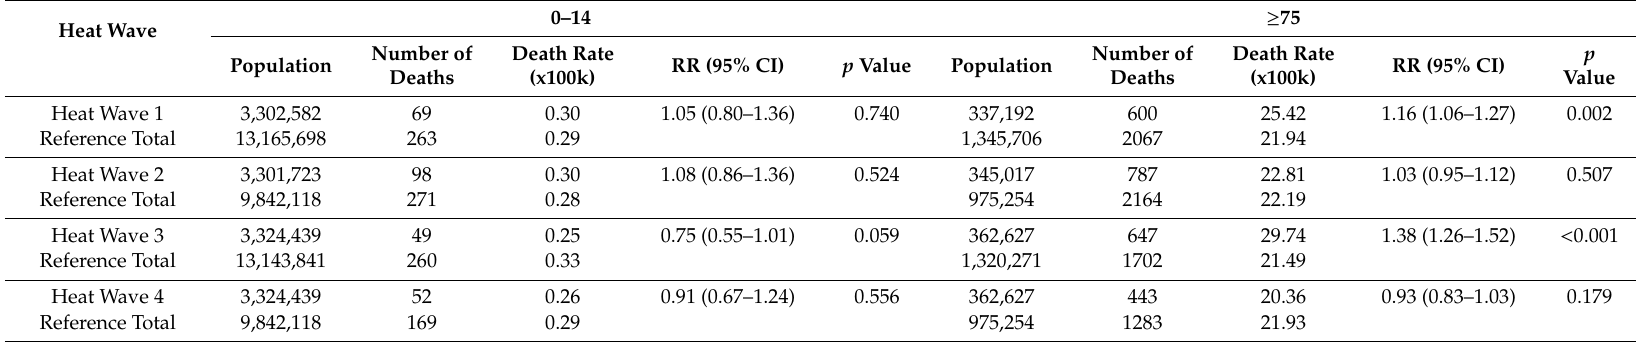
Table 4. Age-specific Death Rates and Risk Ratios of the Extreme Heat Waves between 2013 and